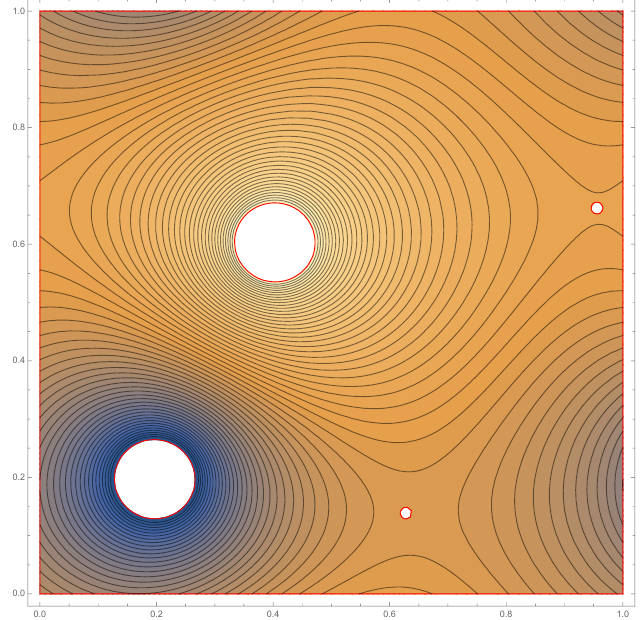
Figure 2 . Curves G = const with τ = i , Z 1 = 0 . 2(1 + i ) , Z 2 = 0 . 4 + 0 . 6 i , P 1 = 0 . 643 + 0 . 129 i and P 2 = 0 . 956 + 0 . 662 i . The big and small white circles represent the positions of the punctures and the zeros of dF ,